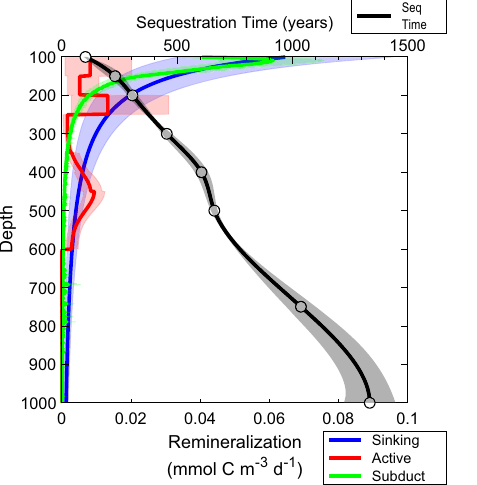
Fig. 2 | Regional average remineralization as a function of depth for the three carbon export pathways (blue=sinking, red=active transport, green= subduction and vertical mixing; bottom axis). Top axis and black line show sequestration duration as a function of remineralization depth. Shaded colors are 95% CI. Source data are provided as a Source Data fi